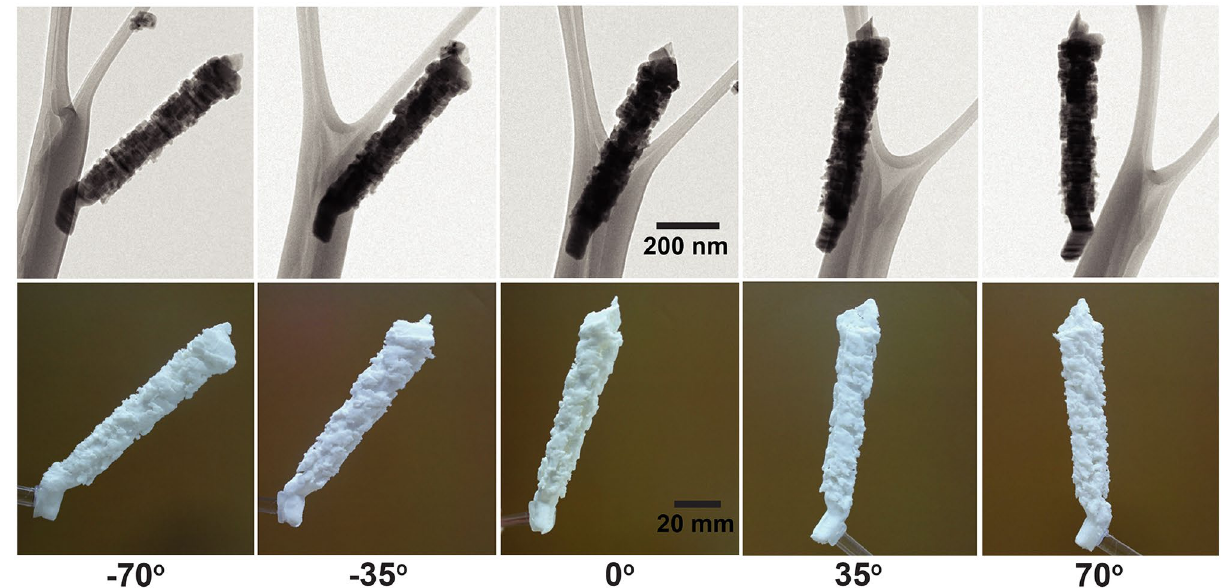
Figure 4. Various tilt angles BF images of a tomographic series (top) and photographs of the 3D printed (magnified over 10 5 scales) hierarchically-assembled ZnS nanostructures (bottom).